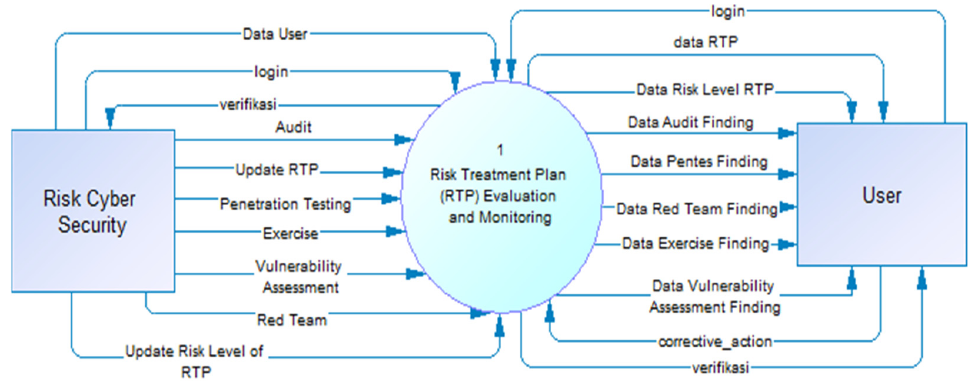
Figure 8. Data Flow Diagram Level 0.